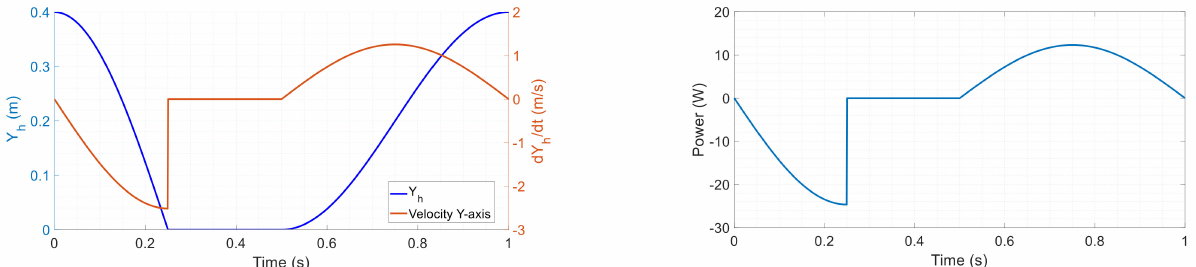
Figure 8. y h and the speed of change of y h with r = 0.2 m and w = 60 rpm ( left ), and power consumption associated with potential energy variation r = 0.2 m, w = 60 rpm, m = 1 kg ( right